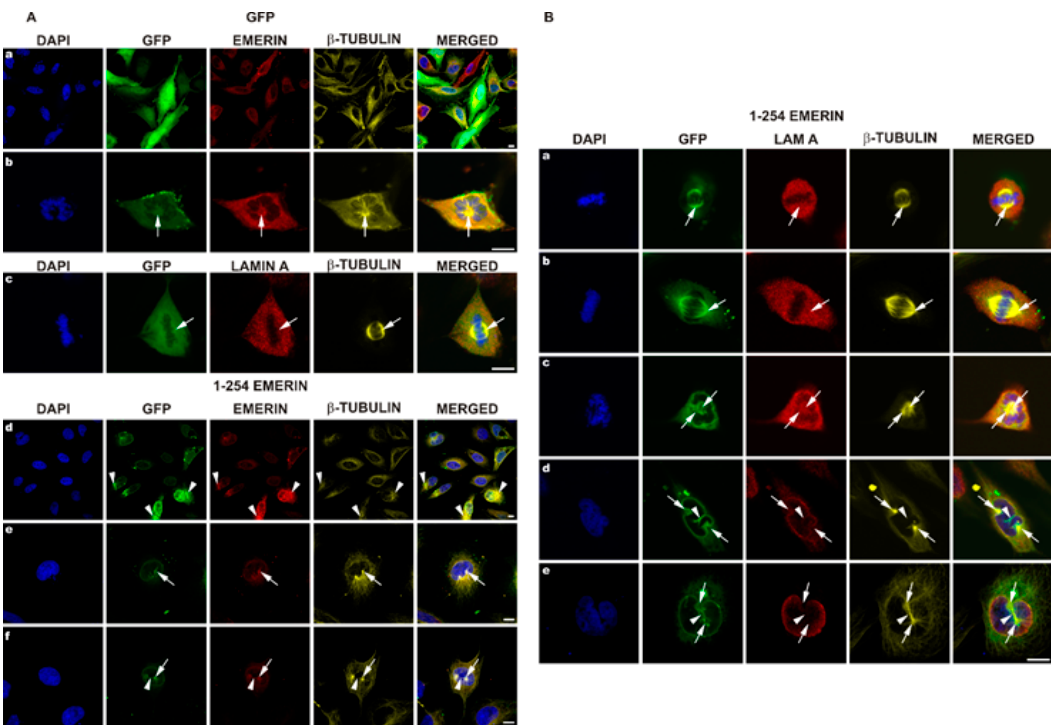
Figure 4. Transfected emerin-EGFP fusion protein associates with microtubules, centrosomes, and mitotic spindle microtubules. HeLa cells were transfected with plasmids encoding EGFP protein alone (Panel A (a–c)) and EGFP-emerin fusion protein (Panel A (d–f) and Panel B ). After 48 h, cells were stained for emerin, tubulin (Panel A) and also lamin A (Ac, B). Fluorescence of the EGFP alone and fusion protein was used to detect the location of a transfected protein (green). Panel A (a–c) demonstrates a typical, dispersed location of GFP protein in transfected cells in interphase and mitotis. Arrows indicate the location of centrosomes and mitotic spindle. Note (b,c) the location of membranes (visualized by emerin staining), emerin and tubulin in the center (b) indicated by an arrow with nice colocalization between emerin and tubulin while EGFP fills the entire space. See also Figure S2d for the similar location of emerin (and LAP2 β ) compared to membranes. Panel A (d–f) demonstrates typical distribution and level of the emerin-GFP fusion protein in transfected cells. In cells transfected with plasmid coding for the fusion protein EGFP-emerin (E1–254) staining for emerin and fusion protein signal (EGFP fluorescence) colocalizes nicely. In cells with a higher level of expression of a fusion protein, deposits of overexpressed emerin protein appear which recruit tubulin to these deposits if present at a high level (see arrowheads in Panel A, d). Note also frequent deformations of nuclear shape in cells overexpressing emerin fusion protein. At prophase (e,f) emerin is still located at the NE but a fraction of emerin associates with microtubules and centrosomes entering the nuclear space (arrows). Arrowhead points to one of the mitotic spindle microtubules associated with emerin (see also Panel B , d,e and Figure 3A, c for comparison). Panel B (a–e) demonstrates typical EGFP-emerin (E1–254) distribution together with lamin A and tubulin staining in mitotic cells. Arrows point to the location of centrosomes and spindle poles. Arrowheads point to the NE invaginations with emerin (d,e), which gradually lost its association with polymerized nuclear lamina as judged by weakening lamin A staining (see also Panel A, e,f and Figure 3A, c for comparison). Note the emerin fraction at the center of the nuclear space in Panel Bc and the disappearing fraction of internal lamin A in this space (see also Figure S2, d for comparison). Note the higher level of transfected emerin associated with mitotic spindle microtubules, which may result from the saturation of “normal” binding sites for emerin and competing for other binding sites. Single Z-section (1.0 μ m) centered at centrosomes (mitotic spindle) is shown. Scale bar, 10 μ m. 3.5. Transient Transfection of Emerin Deletion Mutants Results in a Large Variety of Cellular Phenotypes